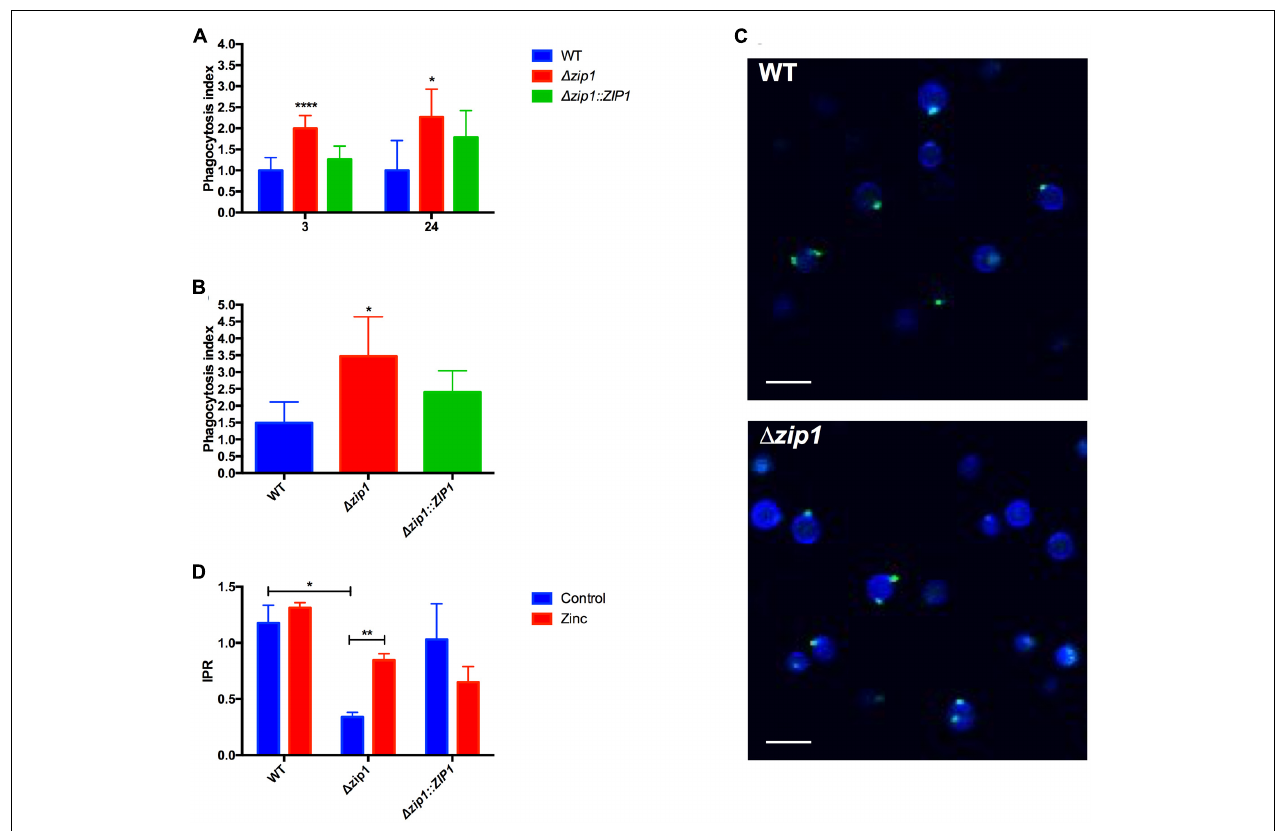
FIGURE 1 | Absence of zinc transporter influences the outcome of Cryptococcus gattii from Acanthamoeba castellanii. (A) Cells of A. castellanii (1 × 10 5 ) were incubated with WT, (cid:49) zip1 or (cid:49) zip1 :: ZIP1 C. gattii strains (1 × 10 6 cells) in PYG medium for 3 or 24 h in 96-well plates to allow phagocytosis. The wells were washed with PBS and A. castellanii cells were lysed. Yeast CFU count was assessed in YPD agar. The phagocytosis index was calculated using the total number of CFUs by the number of protozoan cells. Data are shown as mean ± SD. The asterisks denote statistically significant differences between the (cid:49) zip1 and the WT or (cid:49) zip1 :: ZIP1 conditions ( ∗ p < 0.05; ∗∗∗∗ p < 0.001 as revealed by Student’s t -test). (B) Influence of zinc on the phagocytosis was accessed by culturing cells of A. castellanii (1 × 10 5 ) with WT, (cid:49) zip1 or (cid:49) zip1 :: ZIP1 C. gattii strains (1 × 10 6 cells) in PYG medium added of ZnCl 2 (10 µ M) for 24 h in 96-well plates.